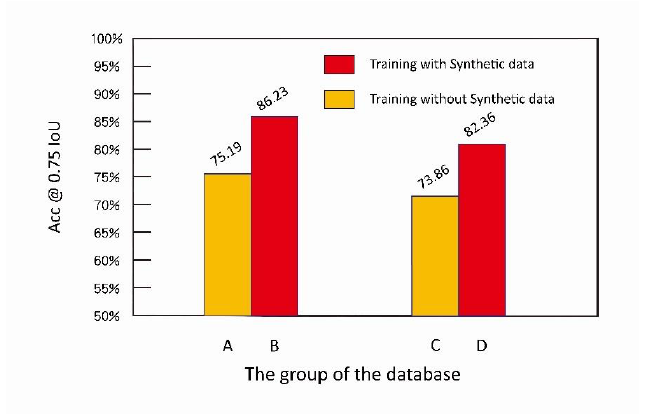
Figure 12 . The total performance of accuracy with Mask-RCNN on CFRP and PLEXI samples Figure 12. The total performance of accuracy with Mask-RCNN on CFRP and PLEXI samples with/without synthetic data . with/without synthetic